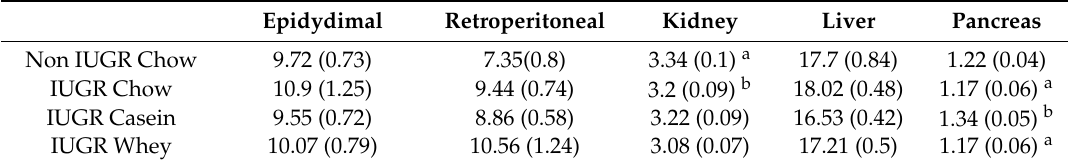
Table 3. Tissue / organ weight at the end of the study (197–199 days).